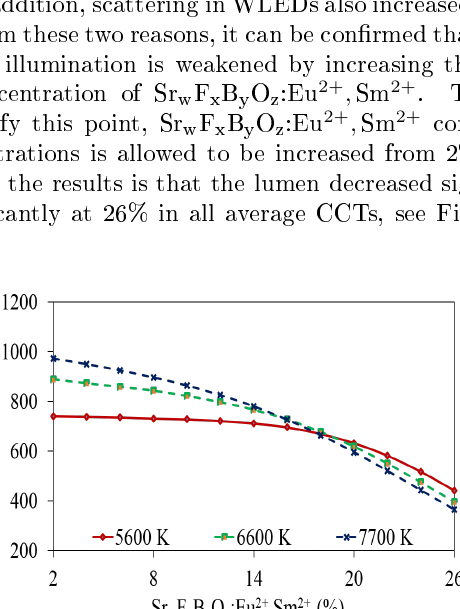
Fig. 8: The emission spectra of 7700 K WLEDs as a function of Sr w F x B y O z :Eu 2+ , Sm 2+ concentra- tion (2% ÷